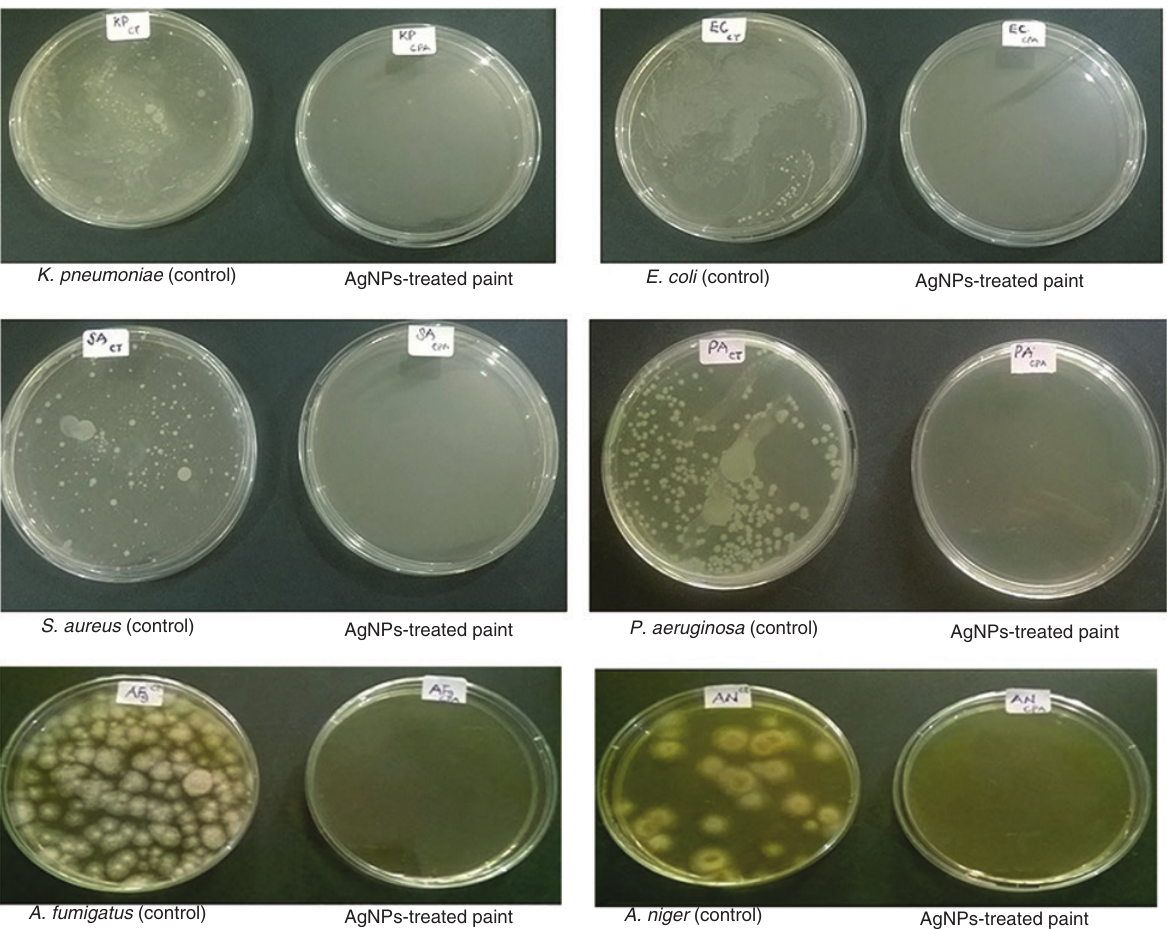
Figure 4: Antimicrobial activities of biosynthesized AgNPs using the cocoa pod husk extract when incorporated as an additive in emulsion